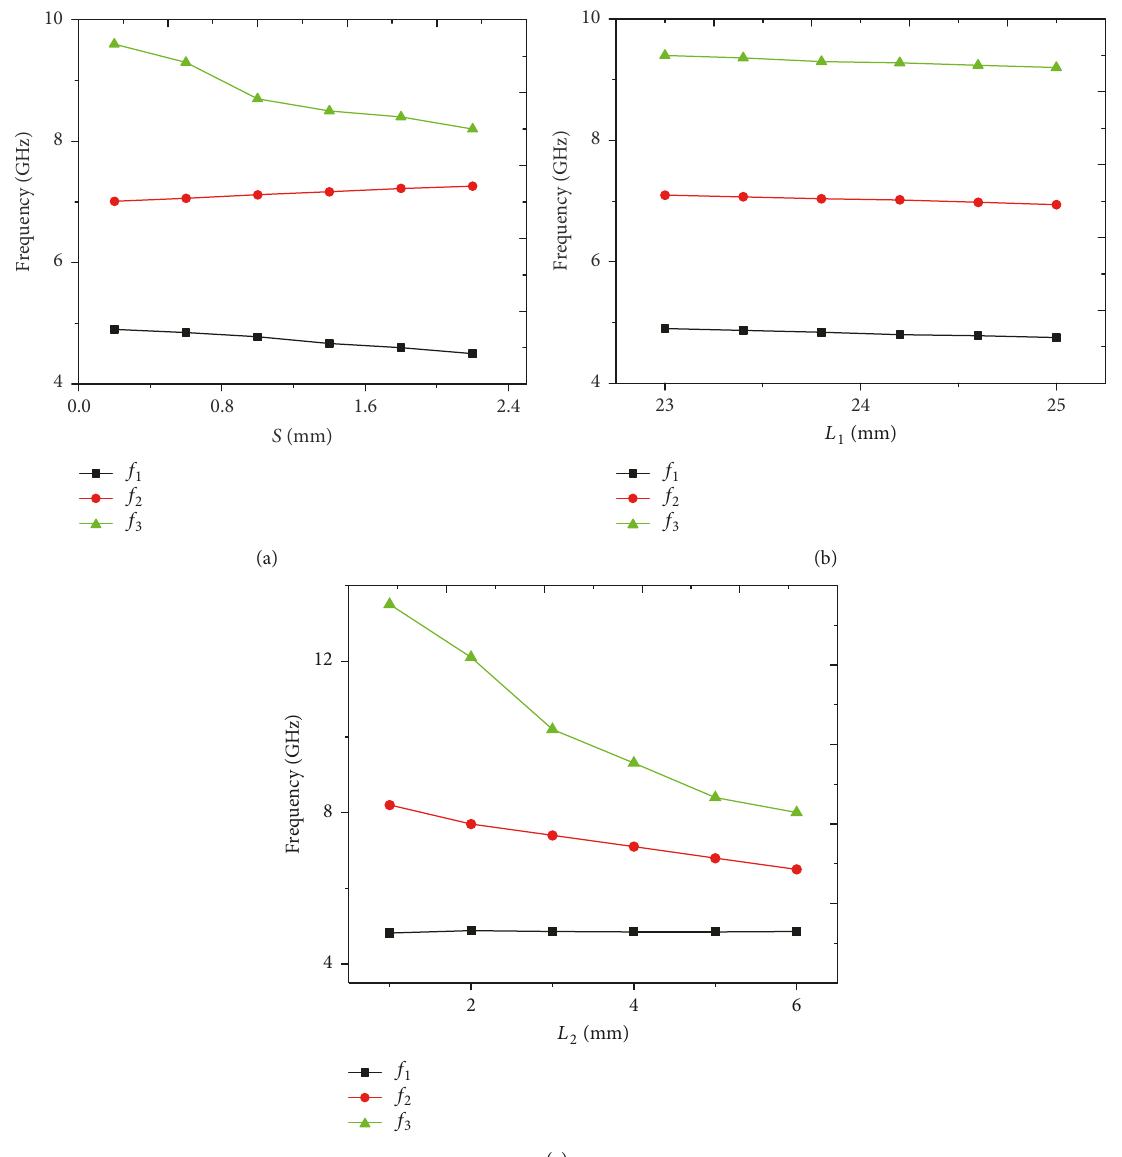
Figure 2: Resonant modes of slotline resonator with fixed 𝑊 1 = 2.0 mm, 𝑊 2 = 0.3 mm, and varied (a) 𝑆 ( 𝐿 1 = 23 mm, 𝐿 2 = 3 mm), (b) 𝐿 1 ( 𝑆 = 0.6 mm, 𝐿 2 = 3 mm), and (c) 𝐿 2 ( 𝑆 = 0.6 mm, 𝐿 1 = 23 mm).